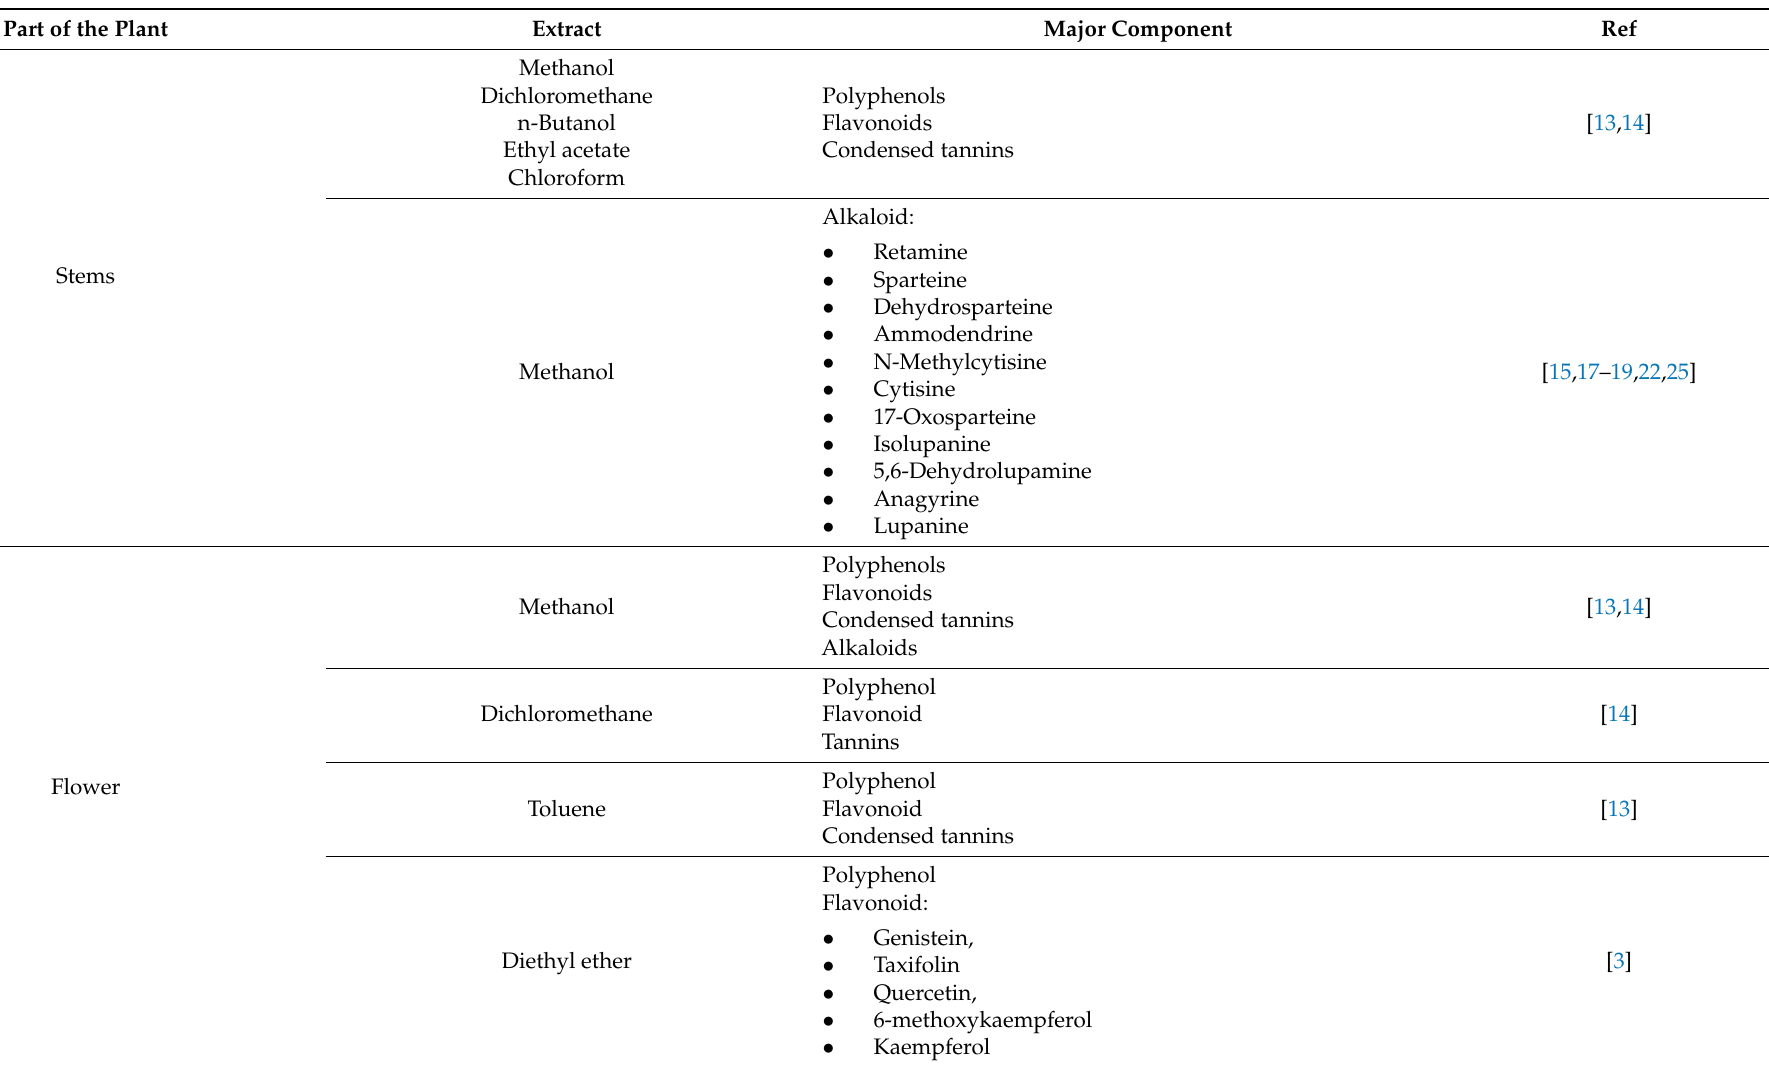
Table 1. Chemical composition of R. monosperma